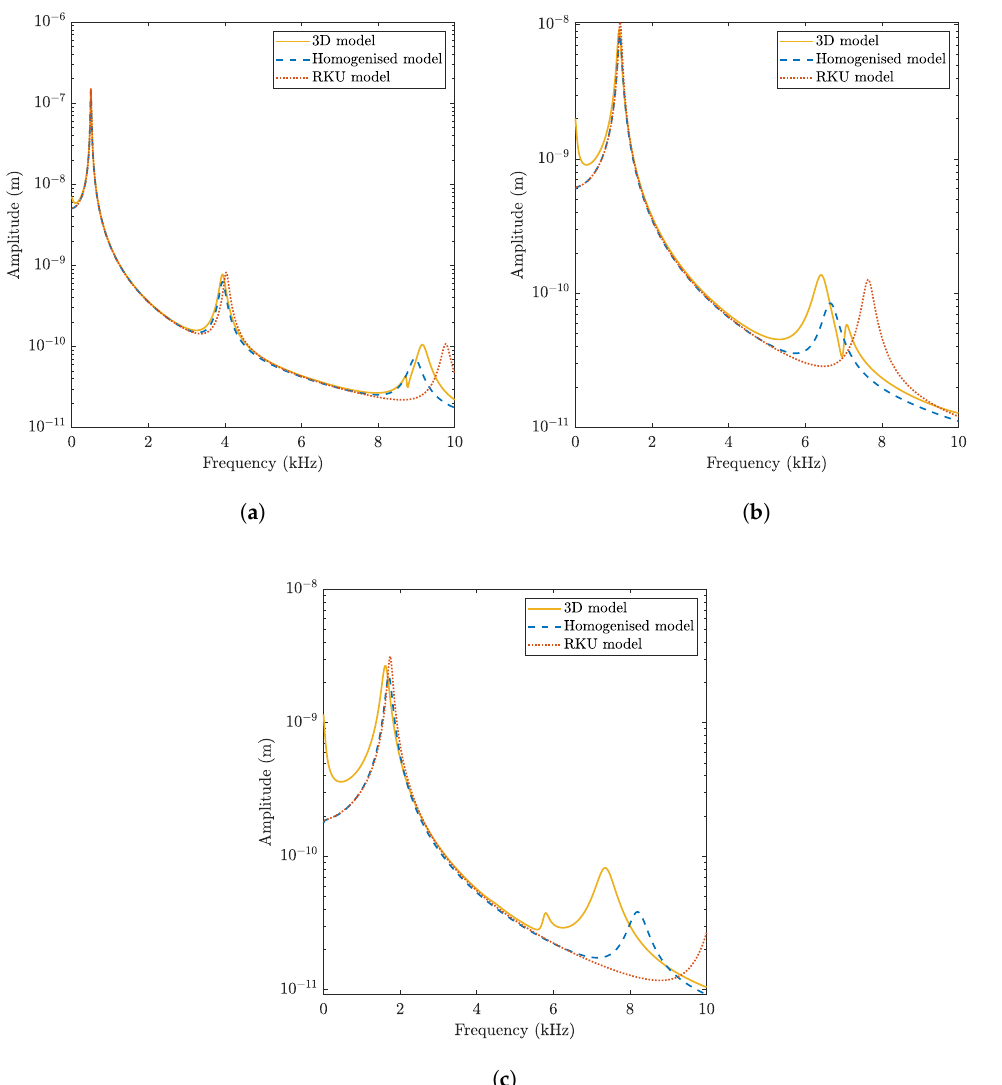
Figure 6. Amplitude of the transverse displacement of the simply supported CLD beam when subjected to a unit pressure: ( a ) H 2 = 1 mm; ( b ) H 2 = 5 mm; ( c ) H 2 = 10